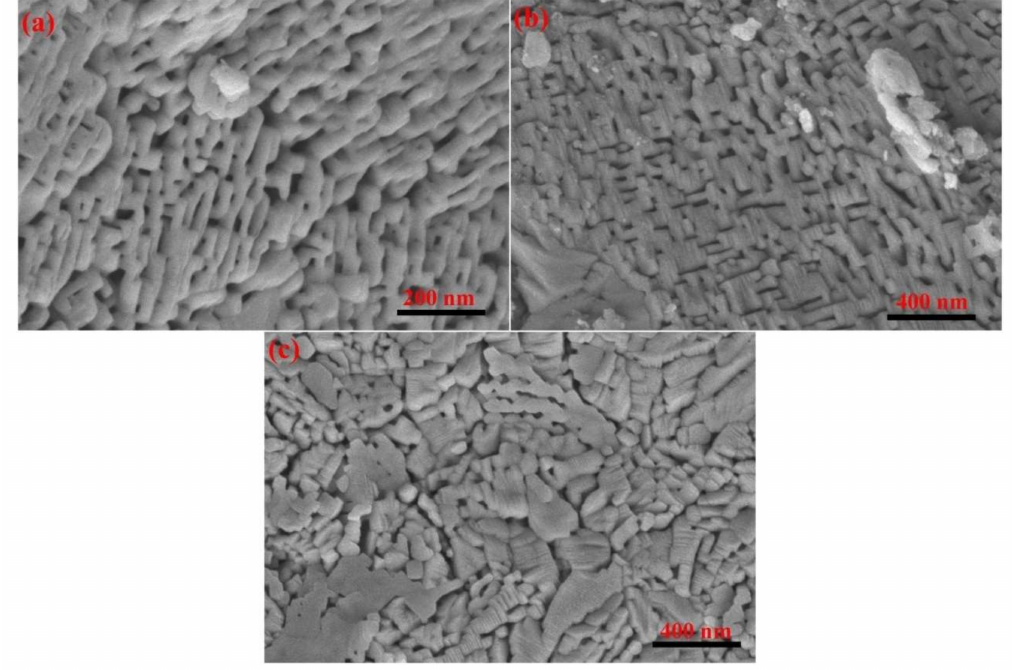
Figure 8. Pores formed by the decomposition of calcium carbonate at the heating rate of 5 K / min ( a ) SEM of calcium oxide from analytically pure calcium carbonate; ( b ) SEM of calcium oxide from calcite crystal powder (No.2); ( c ) SEM of calcium oxide from calcite powder